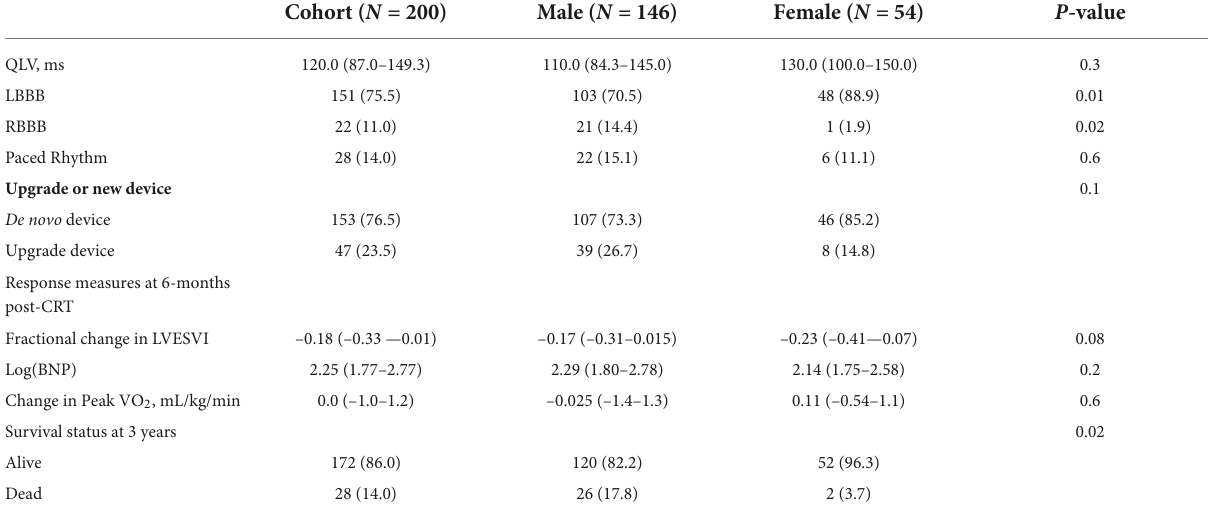
( p < 0.0001), presence of LGE ( p < 0.0001), creatinine ( p = 0.001), prior CABG ( p = 0.004), peak VO 2 ( p = 0.01), presence of LBBB and RBBB ( p = 0.01, p = 0.02, respectively), RVEF ( p = 0.02), African-American race ( p = 0.02), the